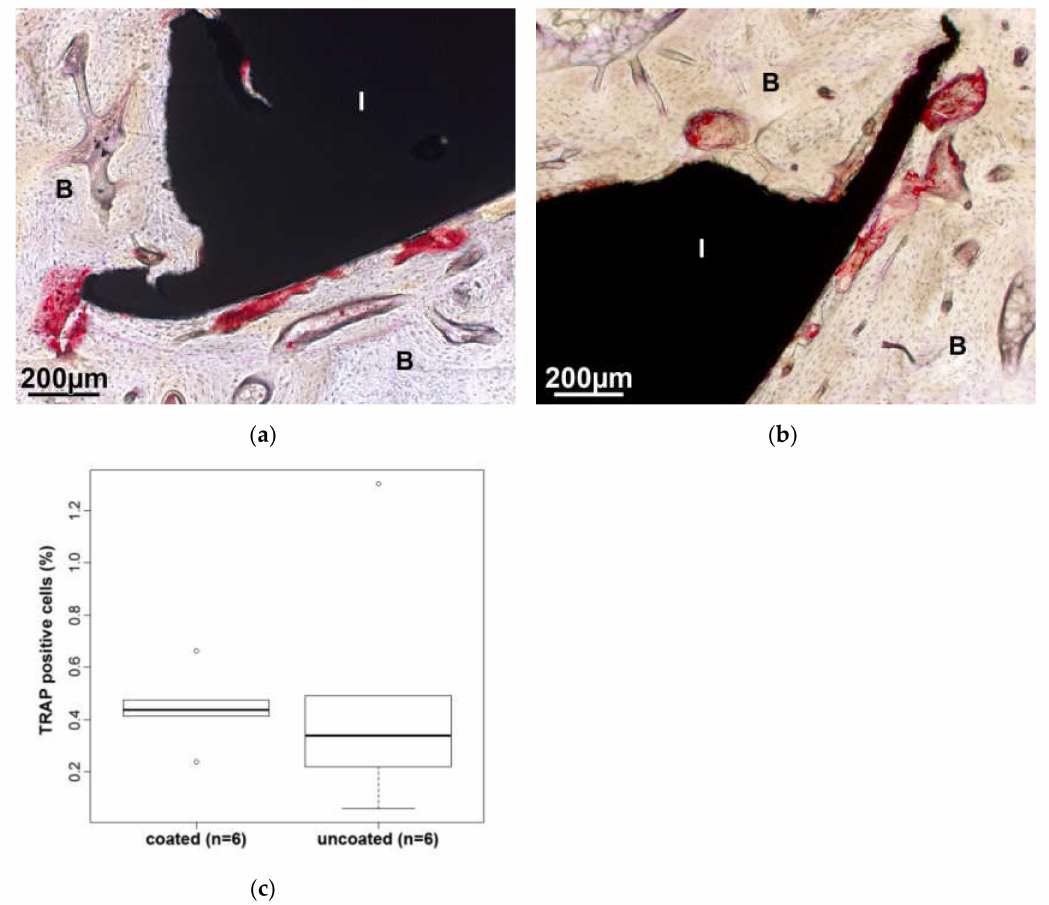
Figure 11. Several red tartrate-resistant acid phosphatase (TRAP)-positive cells are visible lining the coated ( a ) and uncoated ( b ) implant (I). ( c ) The ratio of TRAP-positive cells to bone in the AOI (measured as red areas) shows no significant di ff erences between the two test